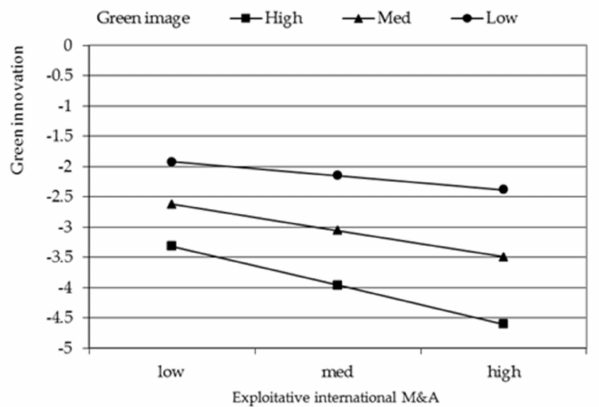
Figure 3. Moderating effect of green image on the relationship between exploitative international M&A and green innovation performance.